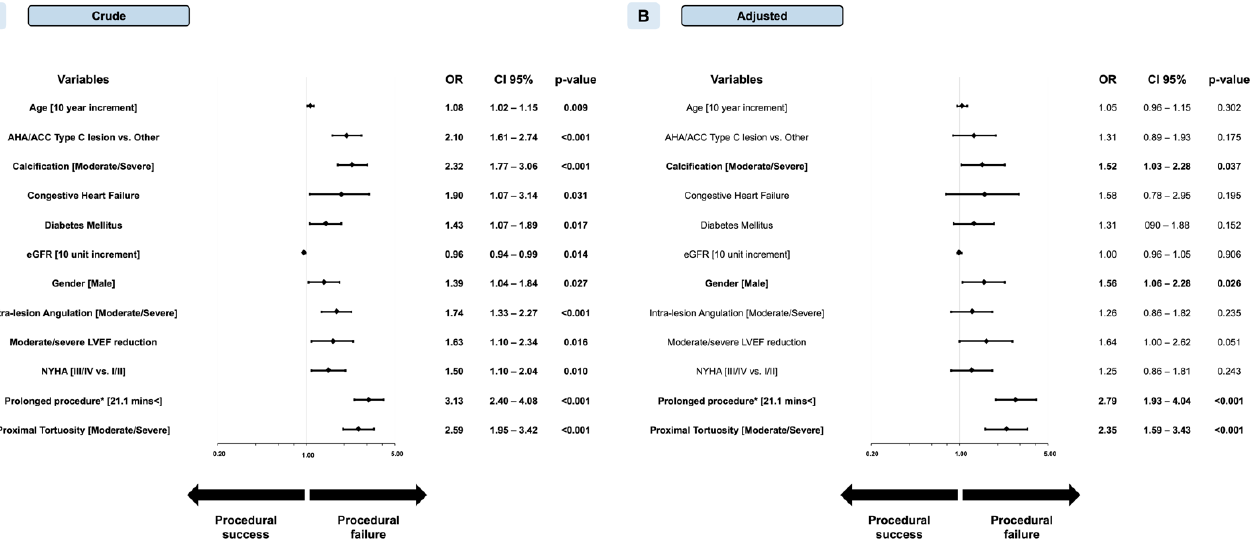
Figure 3. In-hospital outcomes in patients undergoing various length of percutaneous coronary interventions (PCI) tar- geting nonocclusive (Panel A) and chronic occlusive (Panel B) coronary lesions. CTO, chronic total occlusion, and MACCE, major adverse cardiac and cerebrovascular event.